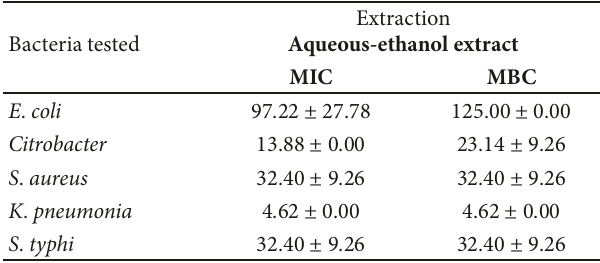
Table 3: The MIC and MBC in (mg/ml) of Sida rhombifolia aqueous-ethanol aerial part extract against tested bacteria. Bacteria